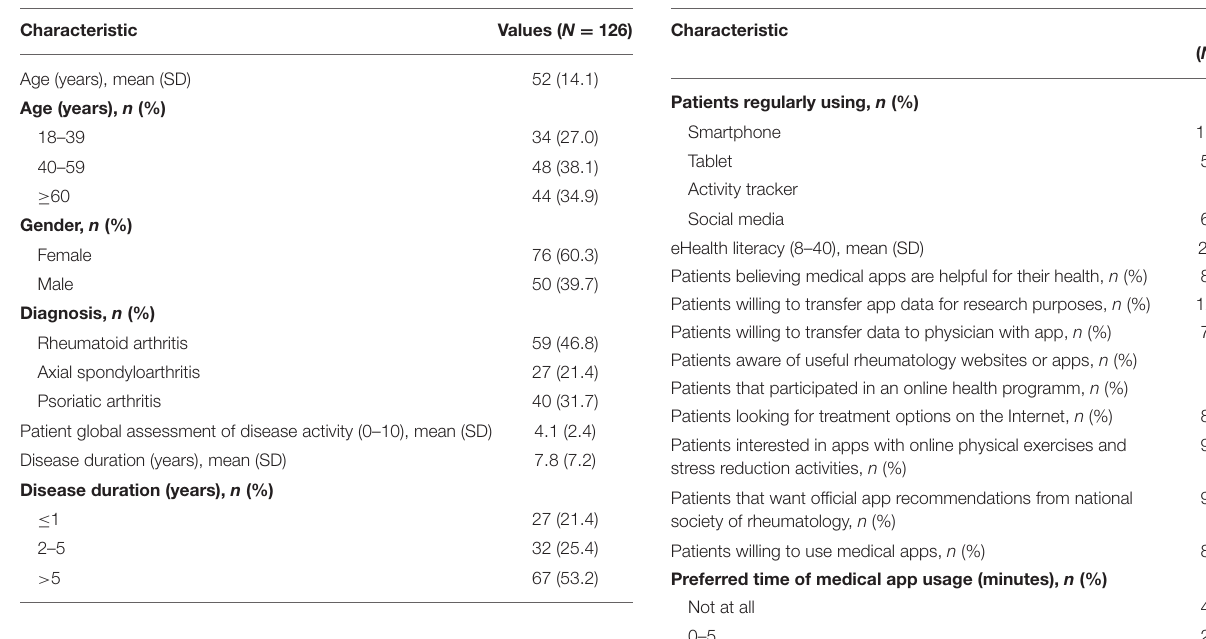
TABLE 2 | Patient mHealth attitude and